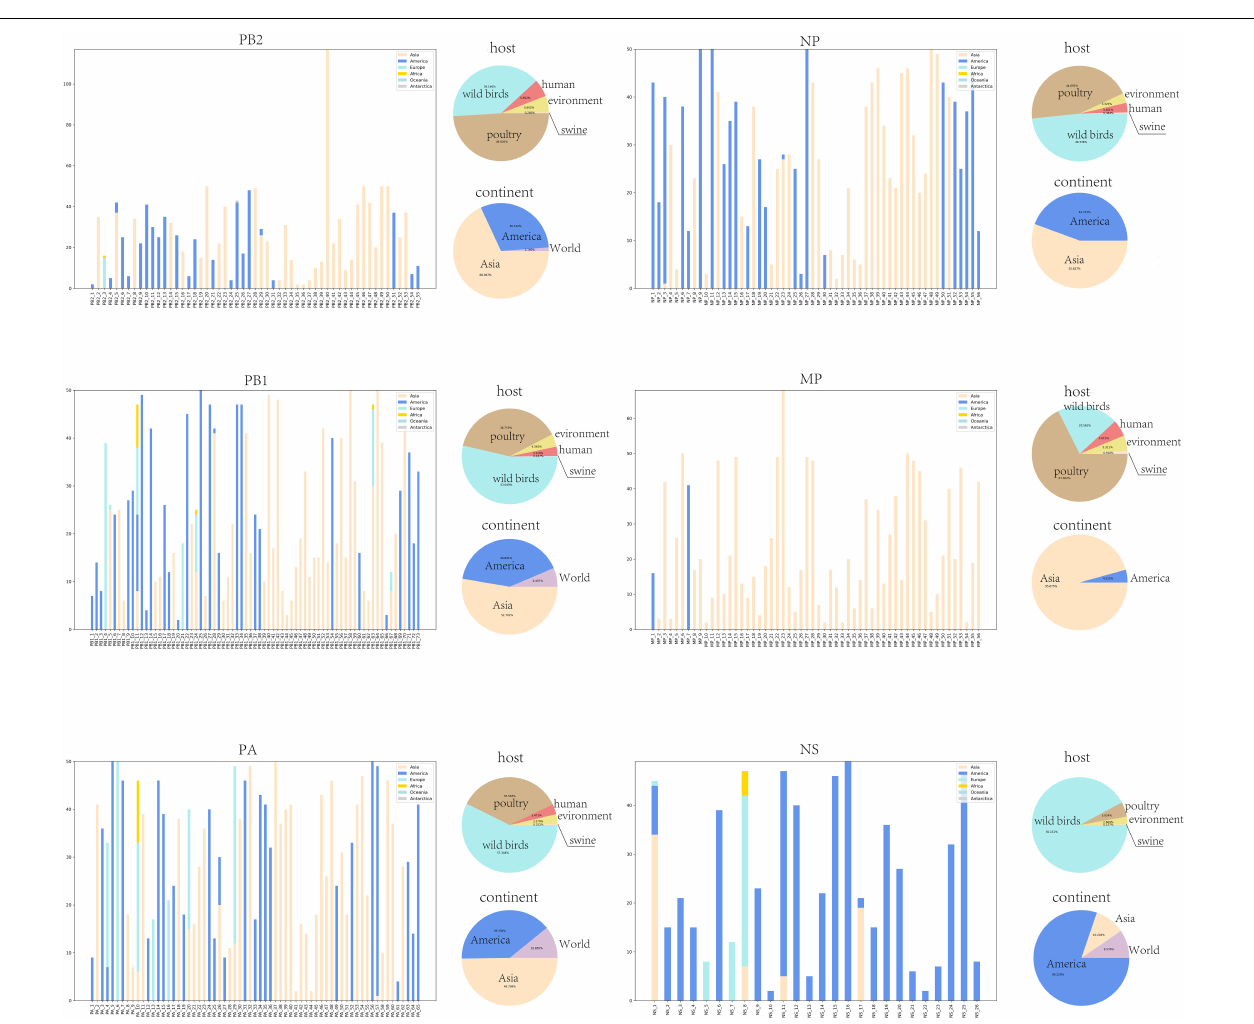
FIGURE 4 | Location and host information for typical clusters. The histogram shows the geographical distribution of each typical cluster and the number of strains contained in corresponding regions. The horizontal coordinate of the histogram is the typical cluster number, and the vertical coordinate is the number of strains contained in different regions. The geographical regions counted in the histogram include Asia, America, Europe, Oceania, and Antarctica. The two pie charts show the host species of all strains and their main geographical distributions. The pie chart of host species counts the proportion of five host species including wild birds, human, poultry, swine, and environment. And the pie chart of geographical distributions counts the proportion of three region types including America, Asia, and World.